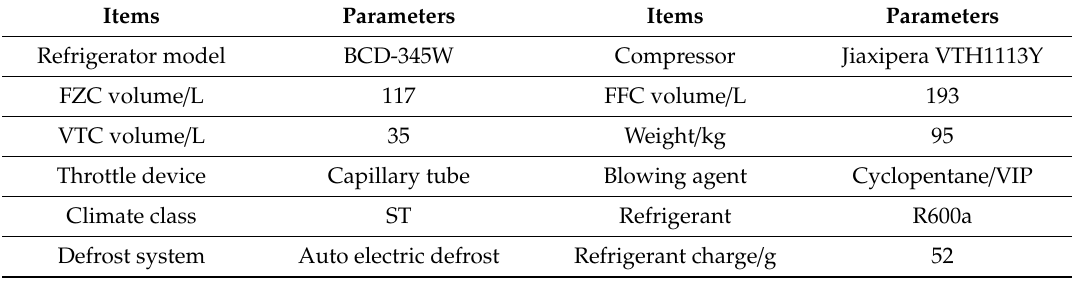
Table 1. Technical specification of the refrigerator.